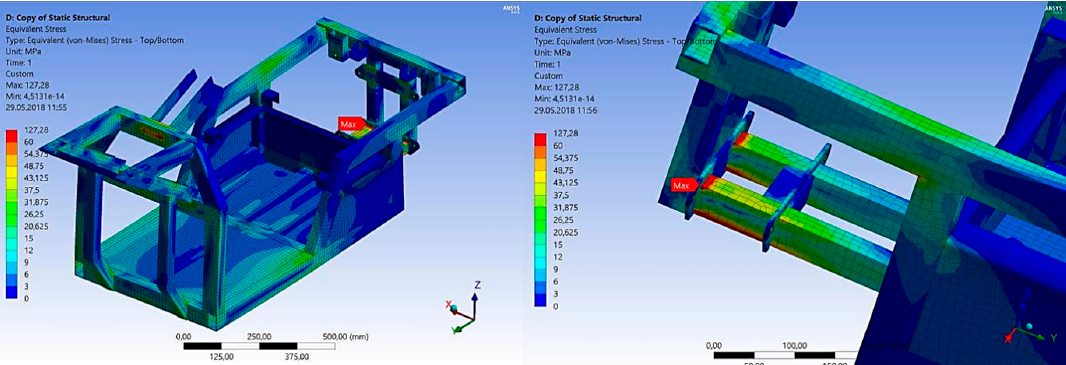
Figure 28. The simulated stresses in the material EN AW 6063.T66 of the frame of the designed vehicle in driving through the curve with the aim of defining the central stress as an independent entry for evaluating the fatigue life, the simulation designed in the finite element software ANSYS 17.2 Workbench.